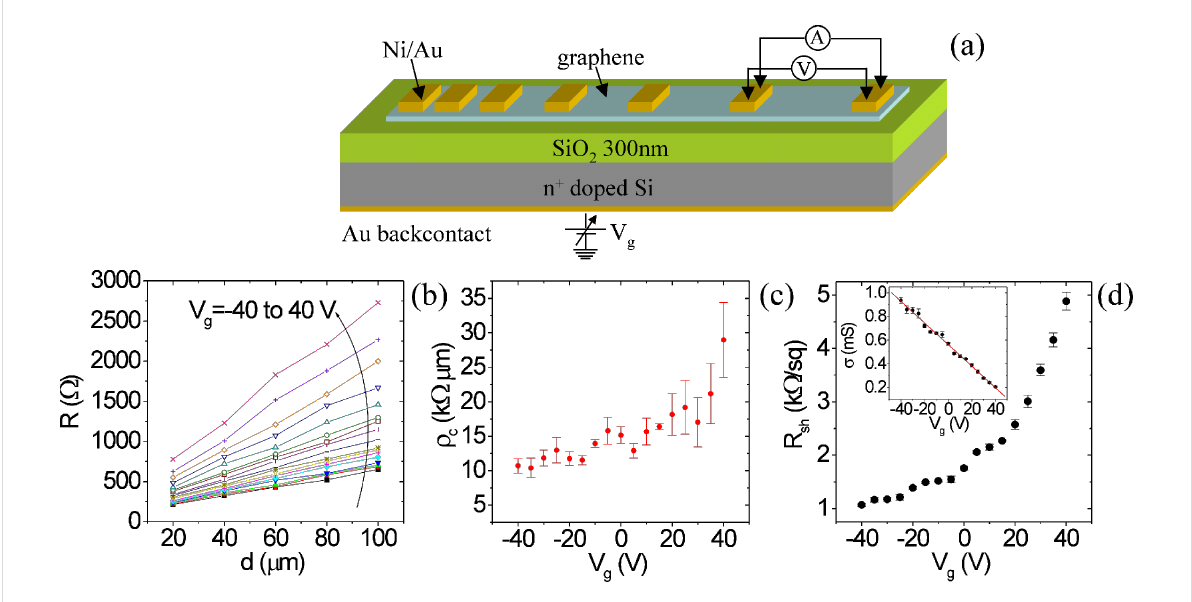
Figure 5: (a) Schematic representation of the back-gated TLM device. (b) Resistance versus distance between adjacent contacts for different V g values from − 40 to 40 V. Extracted specific contact resistance ρ c (c) and sheet resistance R sh (d) versus V g . The insert in (d) displays the linear fit of the conductance data to extract the hole density and mobility in graphene.